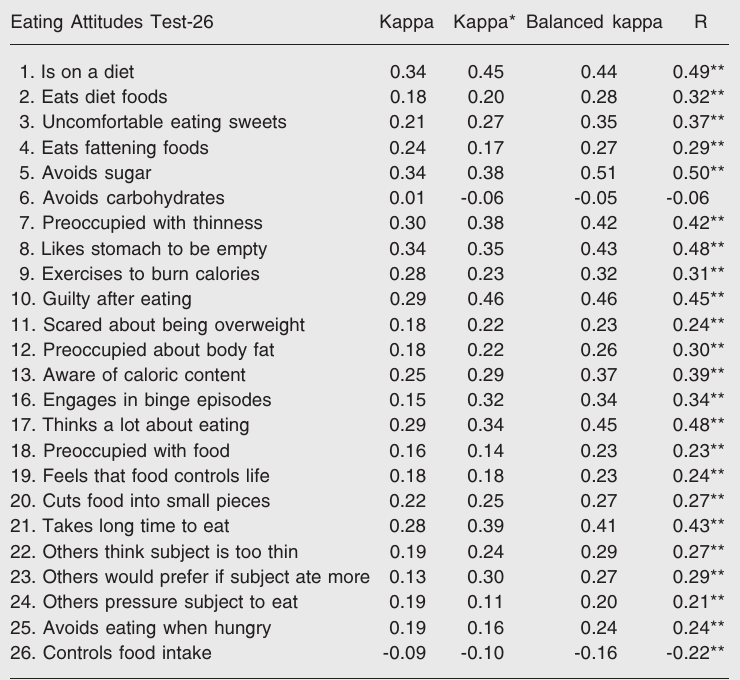
Table 5. Four-year test-retest reliability of the Eating Attitudes Test-26 (1998-2002). Eating Attitudes Test-26 Kappa Kappa* Balanced kappa R 1. Is on a